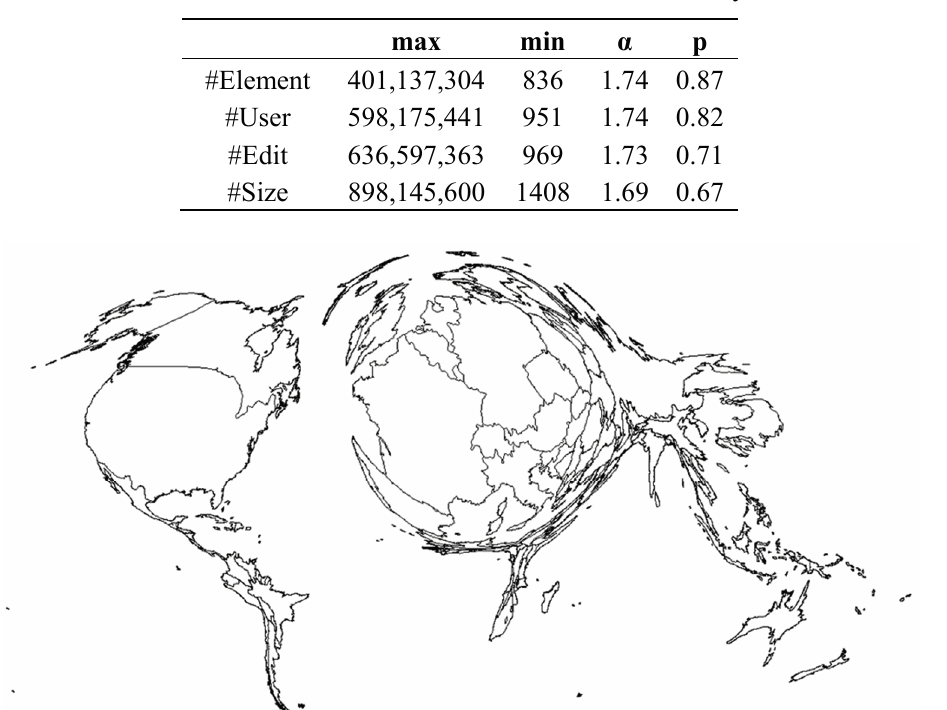
Table 3. Summarized statistics of elements at country level.